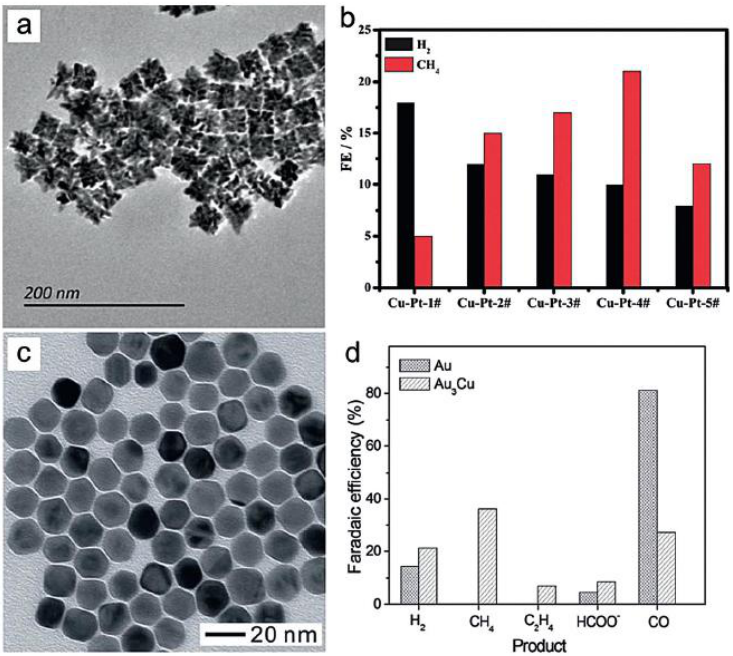
Figure 7. ( a ) TEM images of the Cu-Pt alloy NPs; ( b ) The Faradaic efficiency of H 2 and CH 4 using different Cu-Pt NPs at − 1.6 V. Adapted with permission from Ref. [53]. Copyright 2014, Royal Society of Chemistry; ( c ) TEM image of the Au 3 Cu truncated nanocubes; and ( d ) the Faradaic efficiency of Au 3 Cu and Au NPs for CO 2 electroreduction. Adapted with permission from Ref. [54]. Copyright 2013, Royal Society of Chemistry.